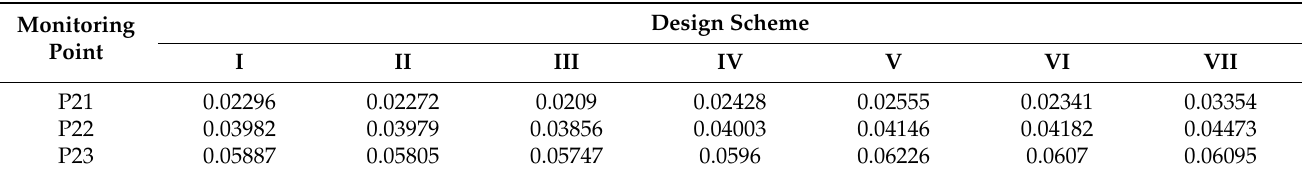
Figure 15. Frequency ‐ domain diagrams of the pressure fluctuations at the impeller outlet: ( a ) Design Scheme I; ( b ) Design Scheme II; ( c ) Design Scheme III; ( d ) Design Scheme IV; ( e ) Design Scheme V; ( f ) Design Scheme VI; and ( g ) Design Scheme VII. Table 5. Amplitude of the dominant frequency at P2. Table 5. Amplitude of the dominant frequency at P2.